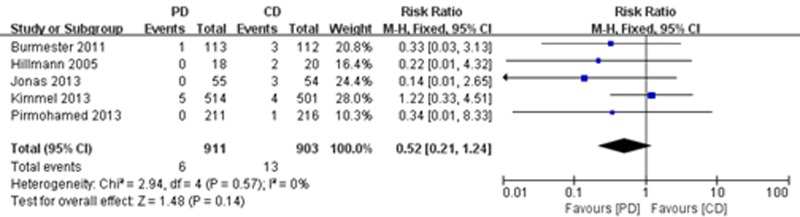
Forest plot of thromboembolism.